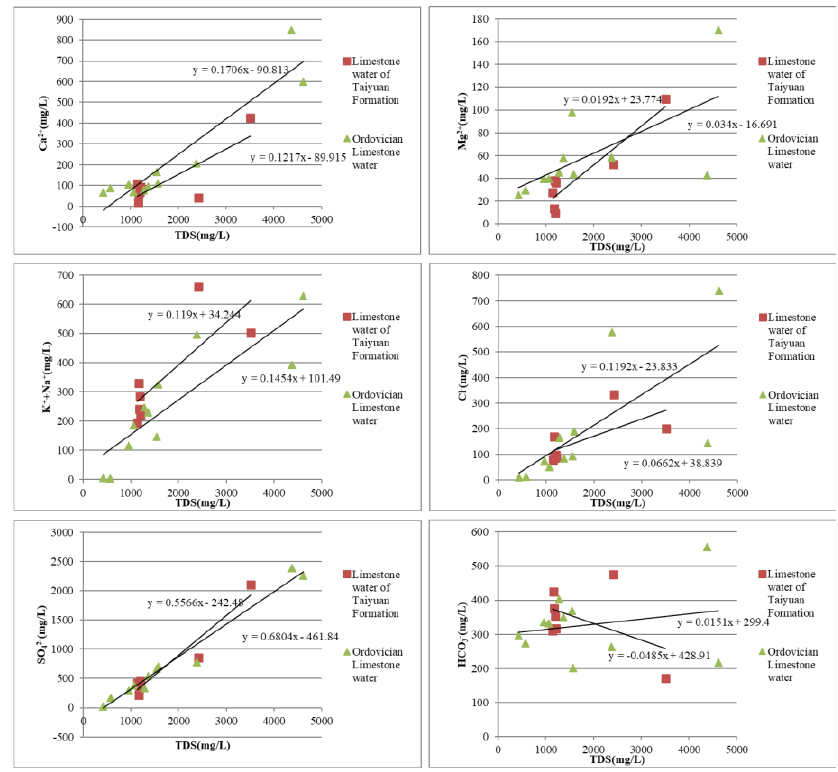
Figure 8. Relationship between conventional ion concentration and TDS in karst water.